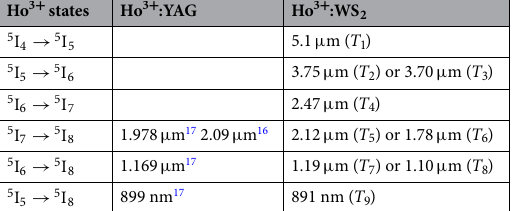
Ho 3 + states Ho 3 +